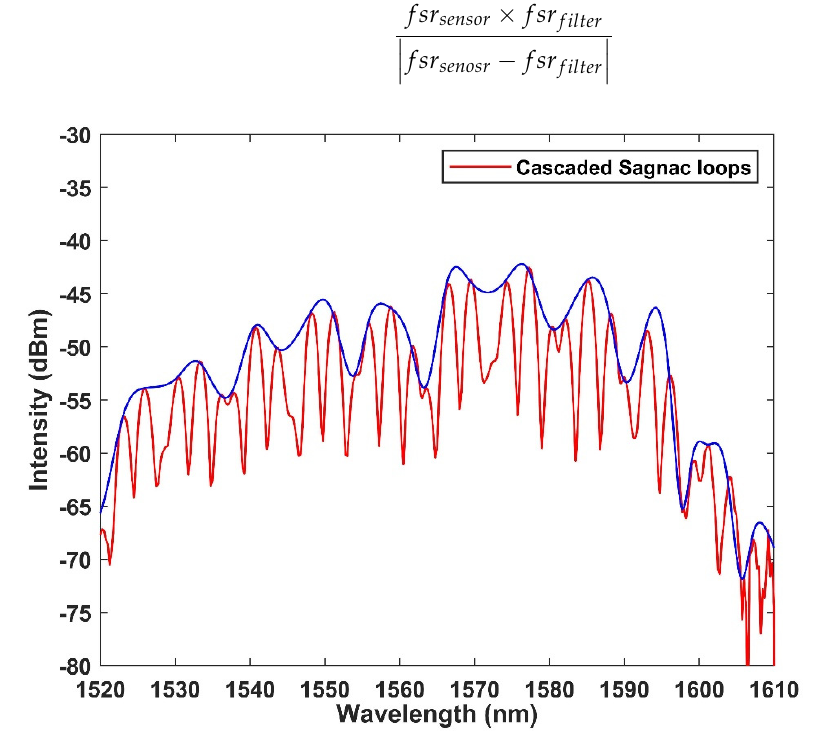
Figure 3. The output spectrum of cascaded Sagnac ring in wavelength domain.